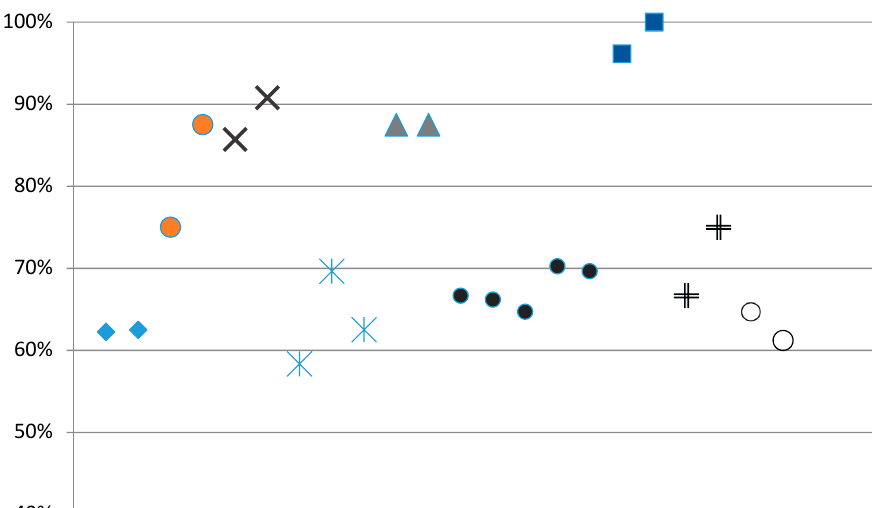
Figure 3. Multiple thaws from same patient are similar. Large adipose samples were stored in multiple smaller aliquots. Individual patients ( n = 9) are shown here as markers of the same style. Tissue yield from thaws procedures on different days show similar recovery levels.